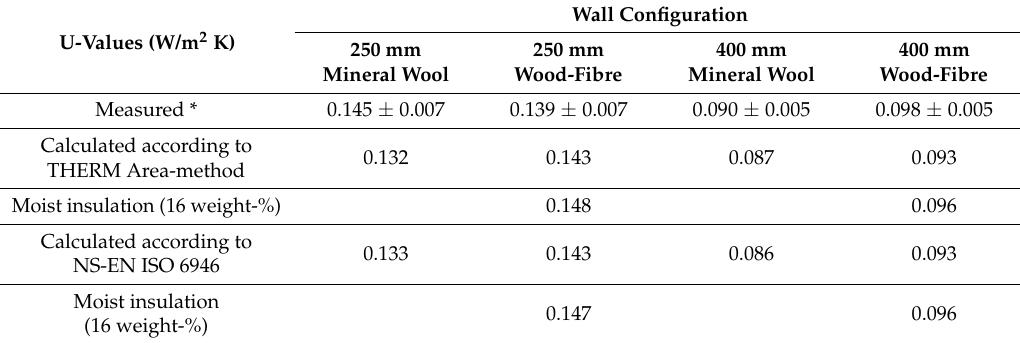
Figure 6. Wood-share and moisture effects on the thermal transmittance (U-value) of the 250 mm ( a ) and 400 mm ( b ) walls. Note the different scales on y-axes.